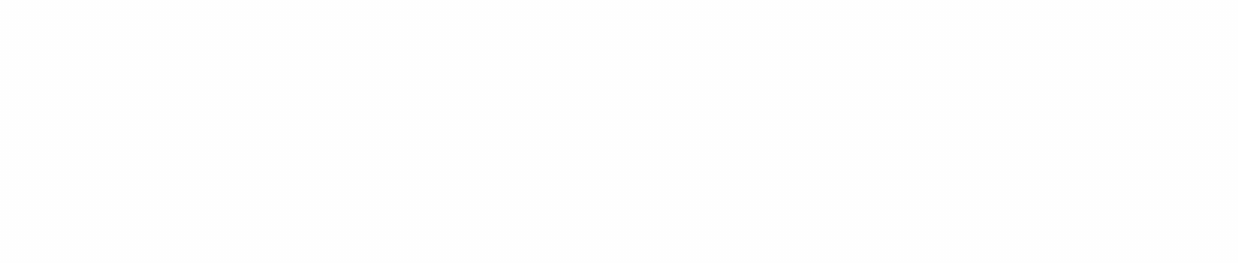
presence of chemokines was compared. The result of the comparison is summarized in fig 2. The different cell lines exhibited typical individual characteristics in cell shape. For example MOLT 4 showed a